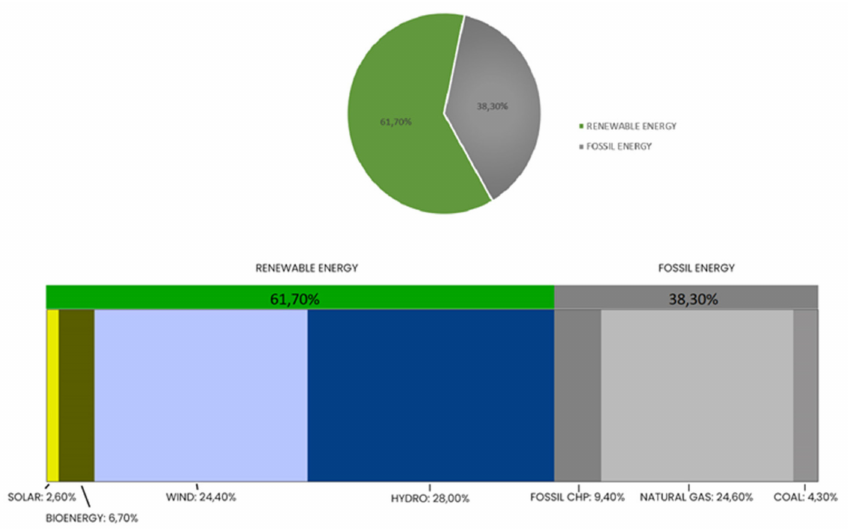
Figure 9. Electricity Generation by Energy Sources in Mainland Portugal-adapted from